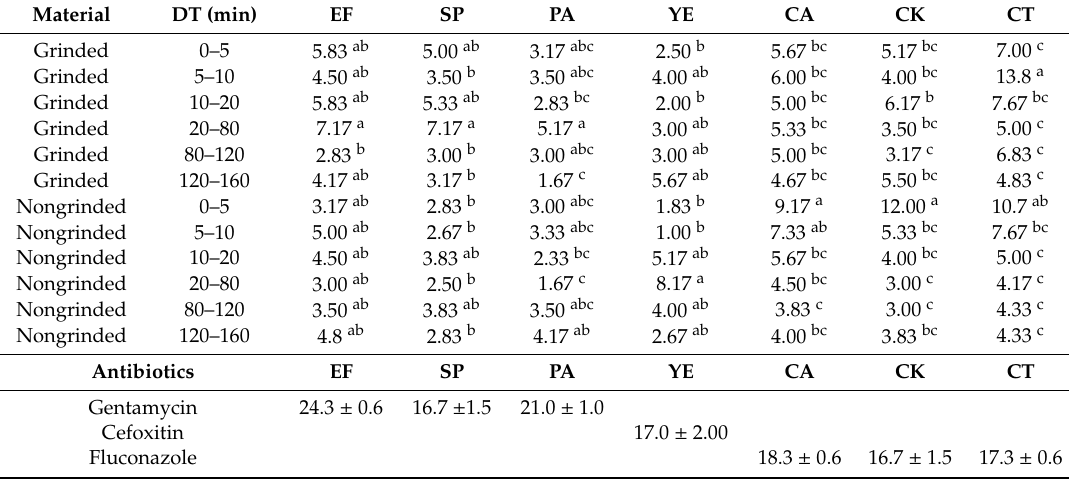
Table 8. Mean values of antimicrobial activities against EF, SP, PA, YE, CA, CK, and CT obtained from the 12 combinations of Material and Distillation time